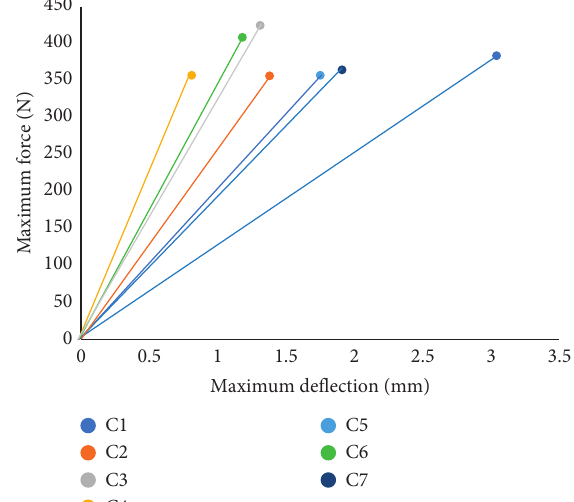
Figure 7: Load versus deflection under shear loading.